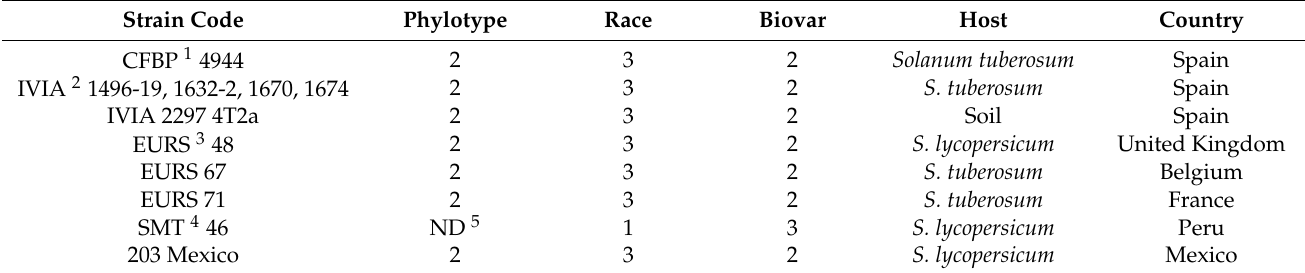
Table 1. Strains of Ralstonia solanacearum used in the present study. Strain